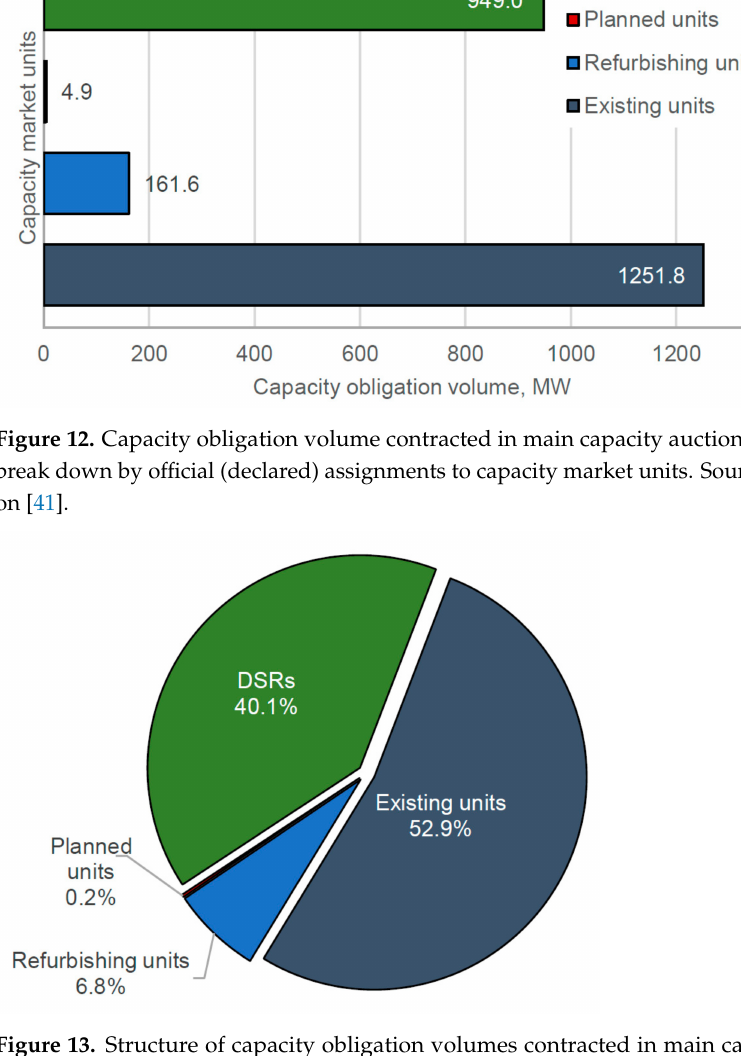
Figure 13. Structure of capacity obligation volumes contracted in main capacity auction for 2025 delivery year; break down by official (declared) assignments to capacity market units. Source: Own analysis based on